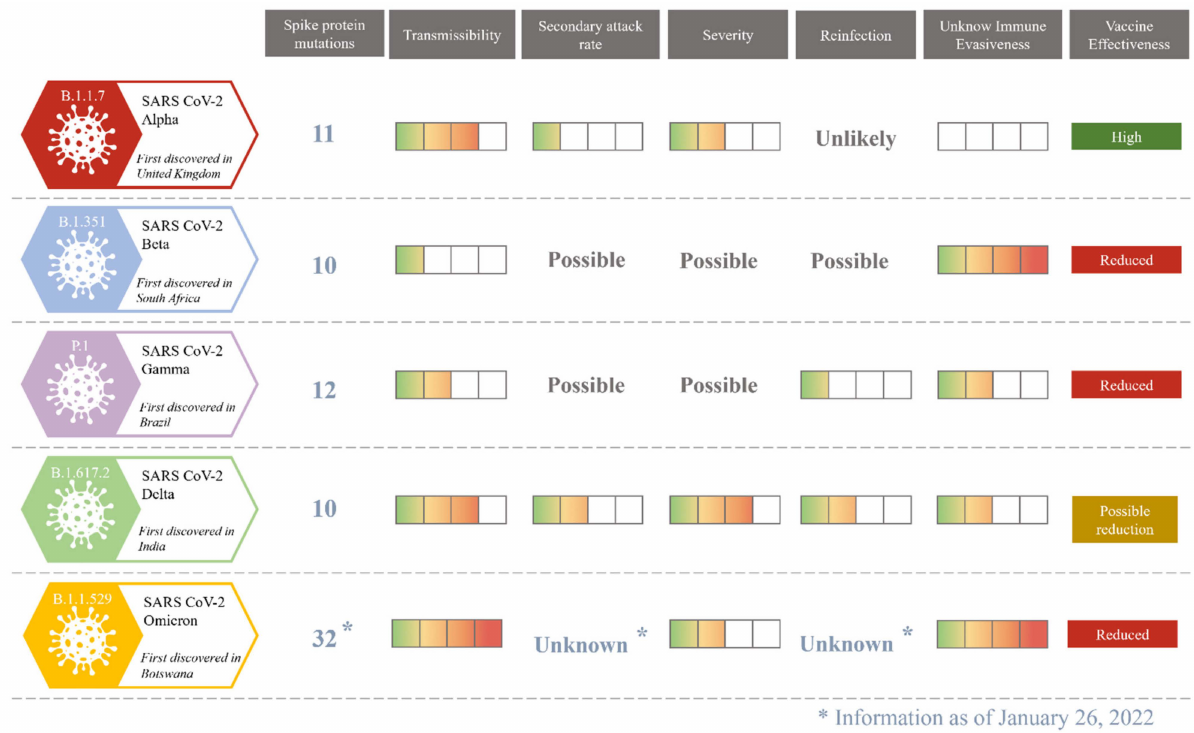
Figure 1. The comparison between currently known SARS-CoV-2 variants of concern. (Spike protein mutations—the number of mutations detected in protein S; Transmissibility—the severity of virus’s infectivity; Secondary attack rate—the probability of the infection among a specific group of people after contact with an infectious person in a household or other close-contact environment; Severity— the probability of severe course of COVID-19; Reinfection—the probability of a second or further development of COVID-19; Unknown Immune Evasiveness—the risk of the virus’s ability to escape neutralization; Vaccine effectiveness—the efficiency of currently investigated vaccines against SARS-